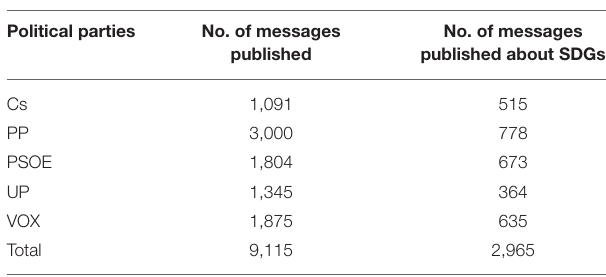
TABLE 2 | No. of messages published by political parties discussing SDGs during General Elections from 2015 to